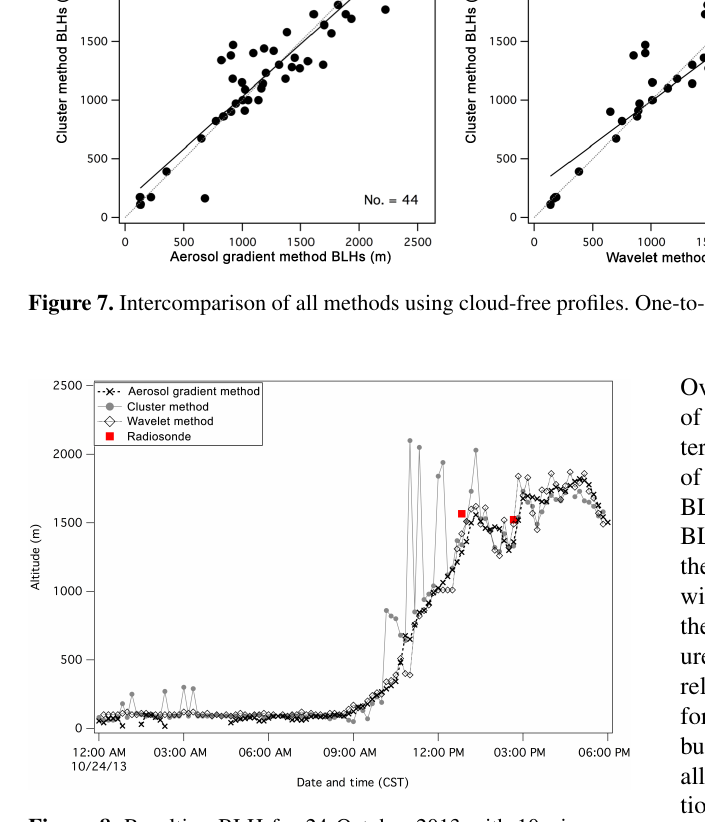
Figure 8. Resulting BLH for 24 October 2013 with 10min aver- ages for all methods. Radiosonde-estimated BLHs are shown as red